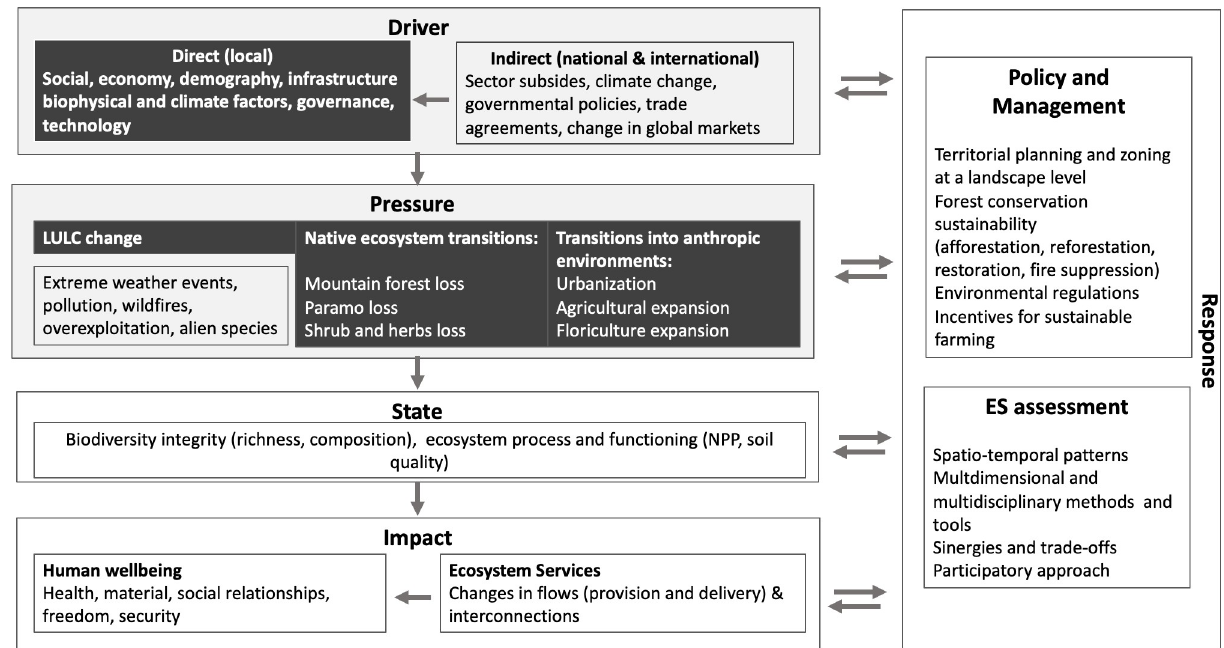
Fig 1. DPSIR framework for ecosystem assessments in tropical mountain systems. Arrows indicate causal relationships between driver, pressure, state, impact, and response (Adapted from [24, 25, 27]).